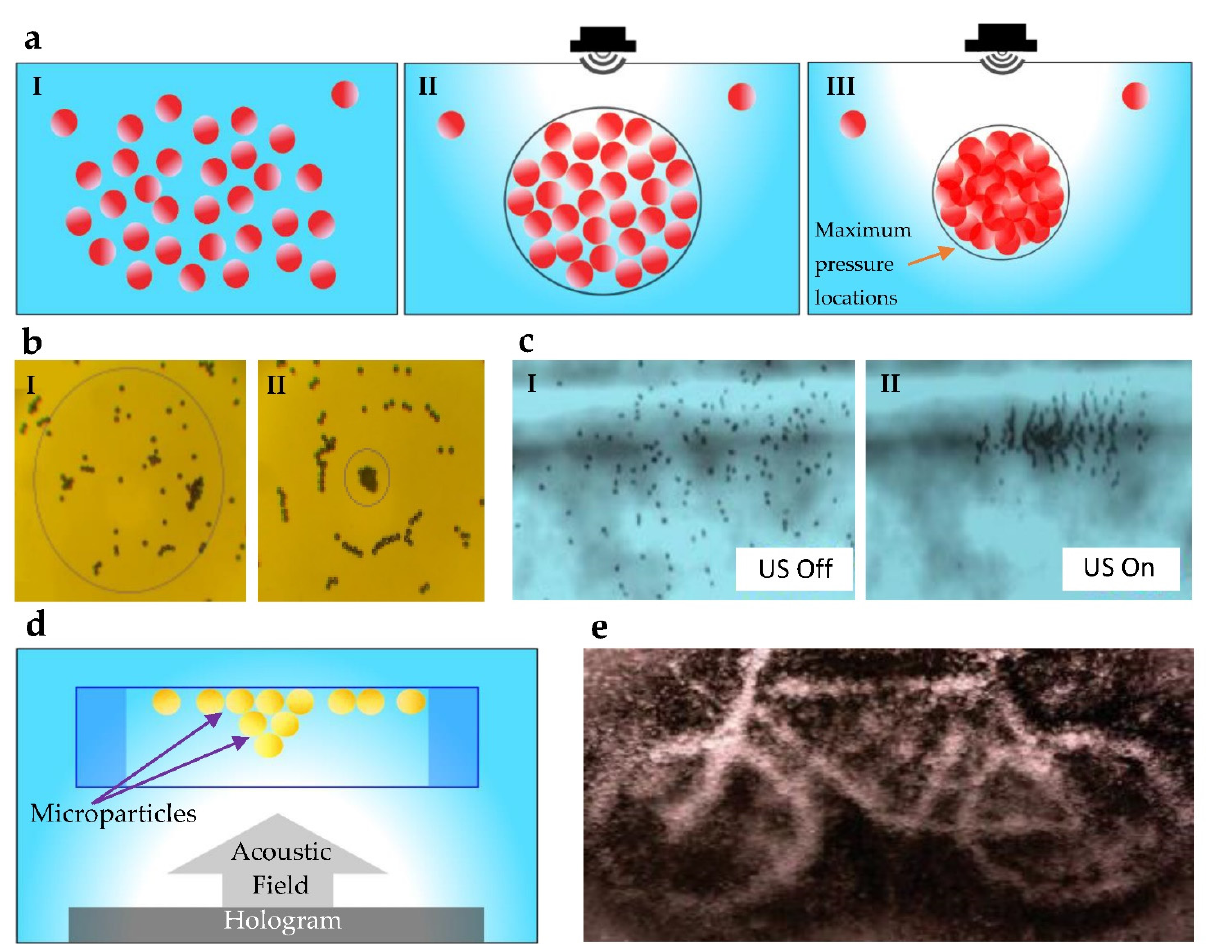
Figure 2. Shape formation techniques using acoustic fields: ( a ) Under an applied acoustic field, particles move towards minimum pressure locations. Circle diameter variation shows the convergence of pressure maxima on the water surface. ( b ) Acoustic traps generate the formation of microparticles by creating pressure minima surrounded by regions of a high pressure amplitude. Reproduced with permission from [69]; published by AIP Publishing. ( c ) Representative example of the rapid-ultrasound-triggered assembly of nanomotors into a swarm. Reproduced with permission from [48]; published by American Chemical Society. ( d ) An acoustic field is applied through the hologram to make target assemblies. ( e ) An arbitrary shape produced using travelling waves (TW) and holograms. Reproduced with permission from [75]; published by John Wiley and Sons.